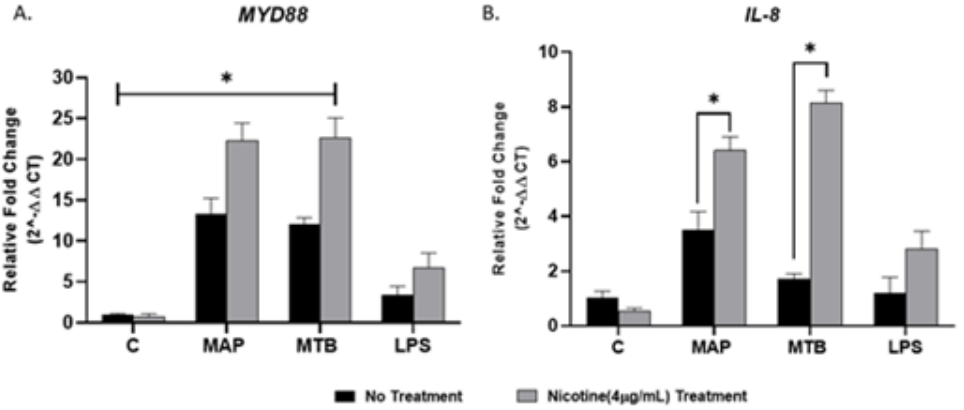
Figure 2. Effect of nicotine on MyD88 signaling and subsequent IL-8 expression in macrophages during infection. THP-1-PMA-differentiated macrophages were infected with MAP and MTB, or treated with LPS for 24 h, then treated with nicotine (4 µg/mL). Expression of MyD88 ( A ) and IL-8 ( B ) were measured by RT-PCR. All experiments were performed in duplicates. MAP: Mycobacterium avium paratuberculosis. MTB: Mycobacteria tubercalusis. LPS: lipopolysaccharide derived from Escherichia coli ATCC 8739. * p < 0.05.